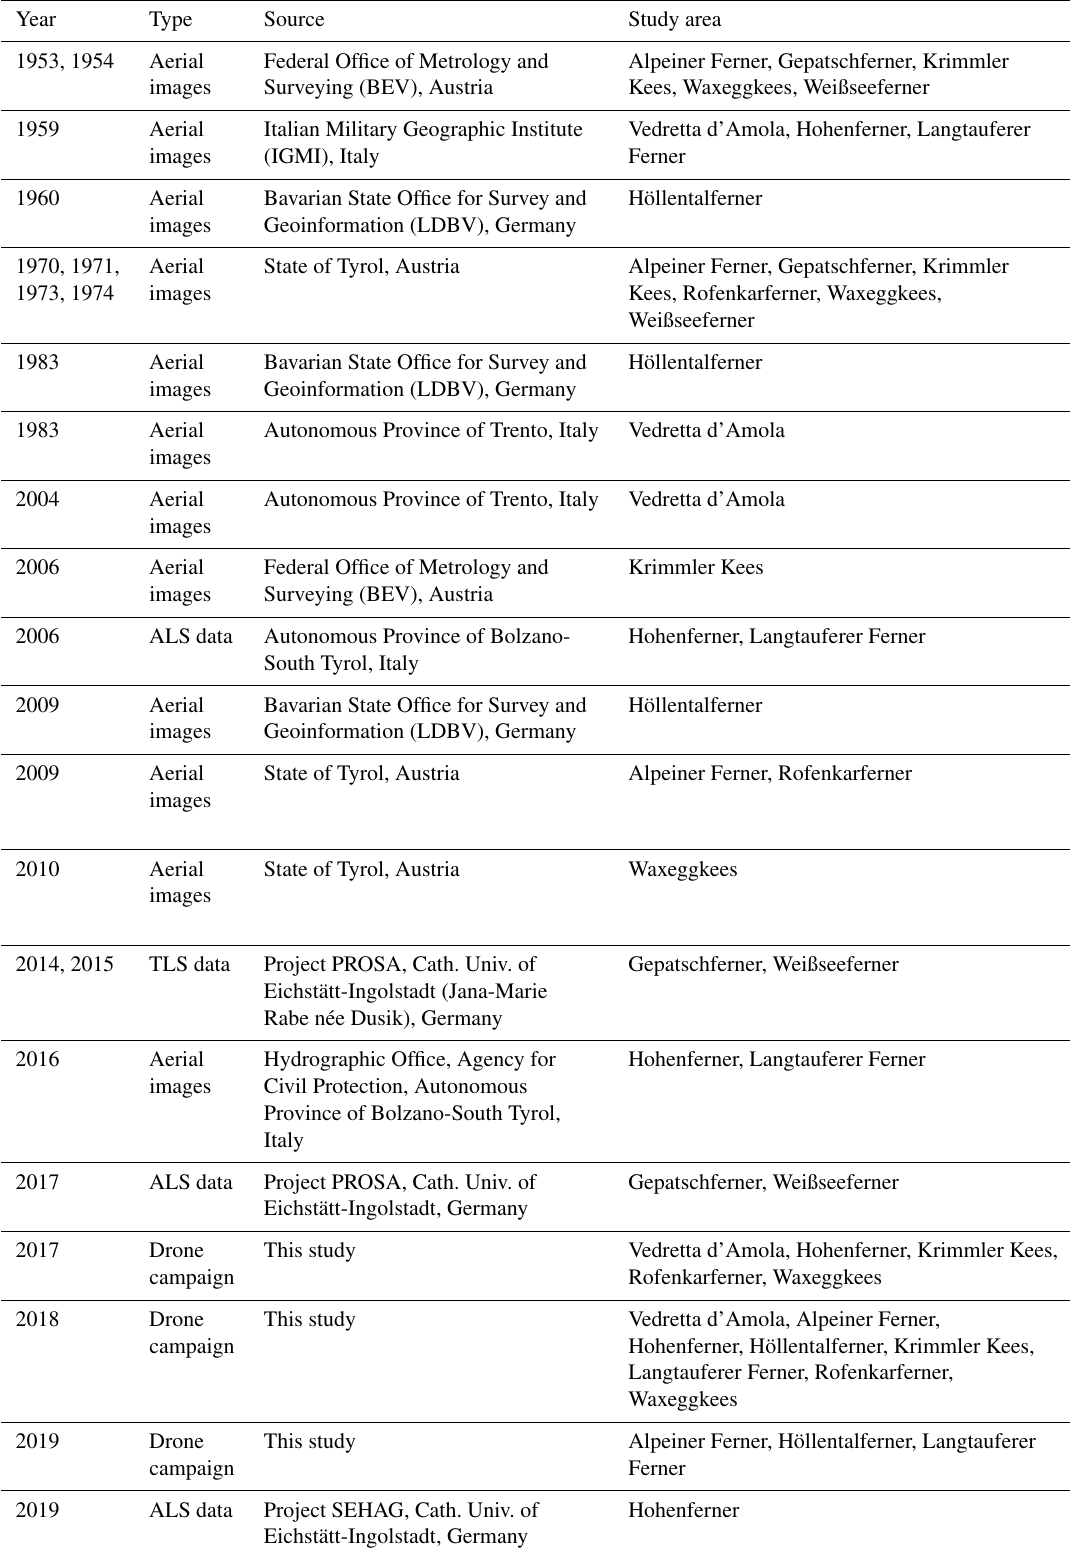
Table 2. Overview of the used aerial image datasets, ALS and TLS datasets, and drone images with the respective years, sources, and study areas. Aerial images and ALS data cover the entire glacier forefields, whereas the TLS data and drone images cover only the selected moraine